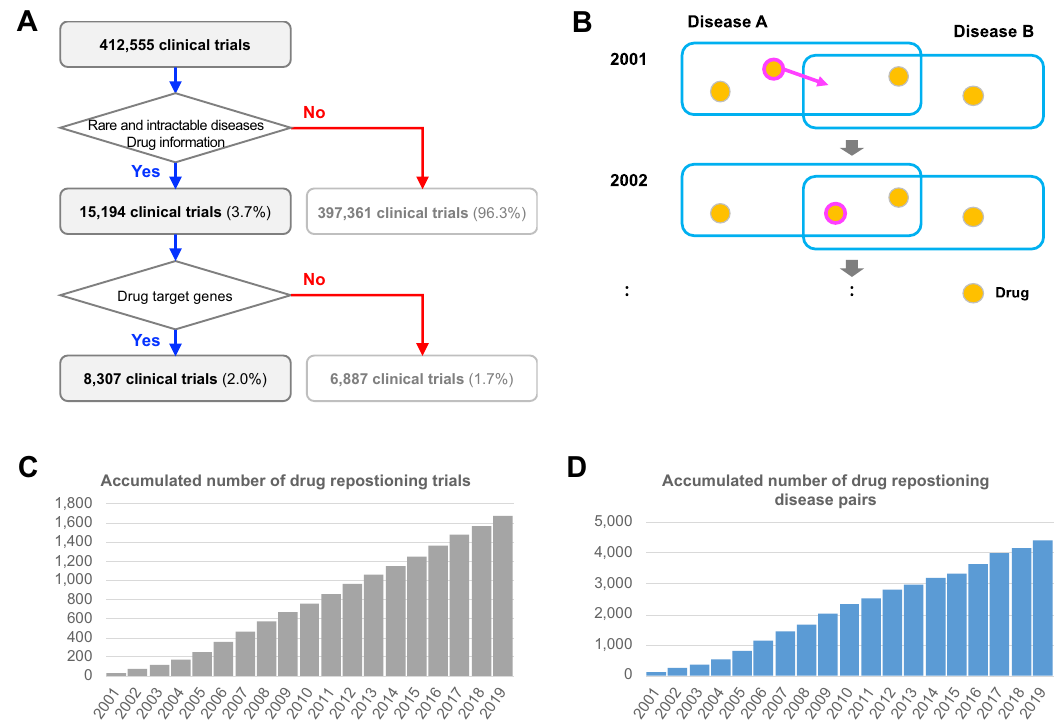
Figure 1. Analysis of drug repositioning in rare and intractable diseases based on clinical trial data. ( A ) Pipeline of extracting information from clinical trials. First, from 412,555 clinical trials in the four registries (JPRN, ClinicalTrials.gov, EU-CTR, and ChiCTR), 15,194 trials which are for rare and intractable diseases and contain drug information were selected. Second, by limiting the drugs to those that have target gene information, 8307 trials containing those drugs were selected. ( B ) Schema of drug repositioning where a drug in disease A is repositioned to disease B. A drug repositioning occurs when a drug which formerly tested for a disease newly becomes shared. ( C ) Accumulated number of clinical trials identified as drug repositioning trials enrolled annually in recent 20 years. In total, 1676 clinical trials were identified during the period. ( D ) Accumulated number of disease pairs combined for drug repositioning first appeared during the period. In total 4401 disease pairs were counted during the